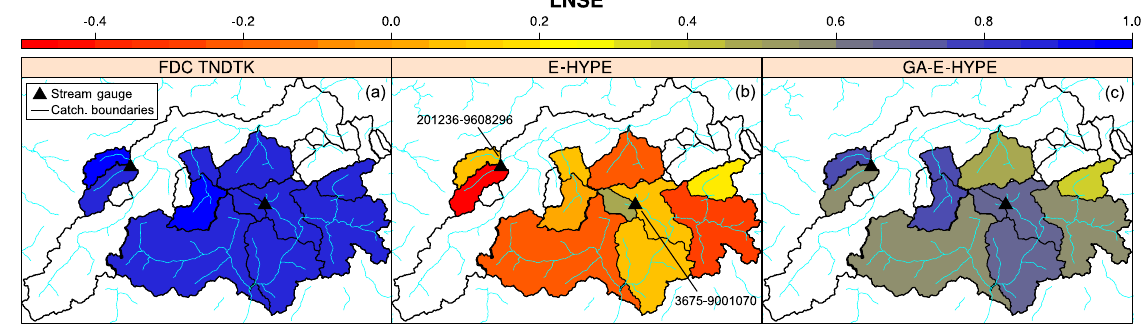
Figure 10. Spatial distribution of Nash–Sutcliffe efficiency computed for log-transformed streamflows (LNSEs) at the 11 E-HYPE prediction nodes considered in the study: geostatistically predicted flow–duration curves (FDC TNDTK, a ); predicted daily streamflow time series (E- HYPE, b , and GAE-HYPE, c , respectively); the locations of the two sites considered in Figs. 9 and 8 are highlighted with black